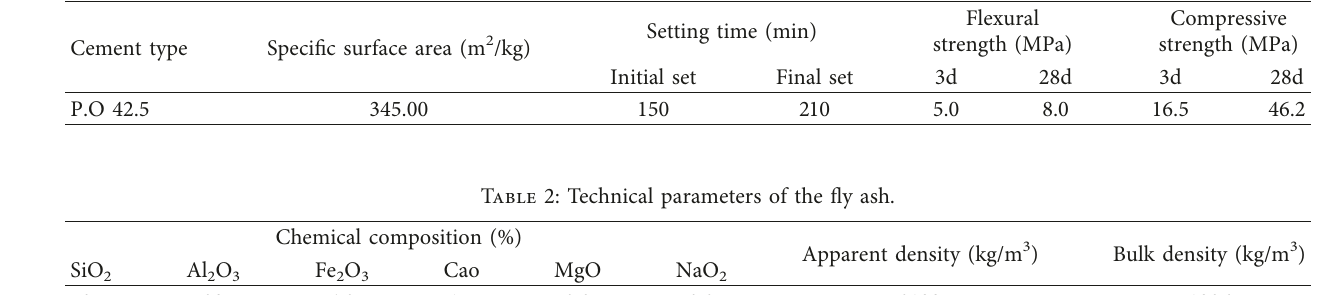
Table 1: Physical and mechanical properties of ordinary Portland cement.